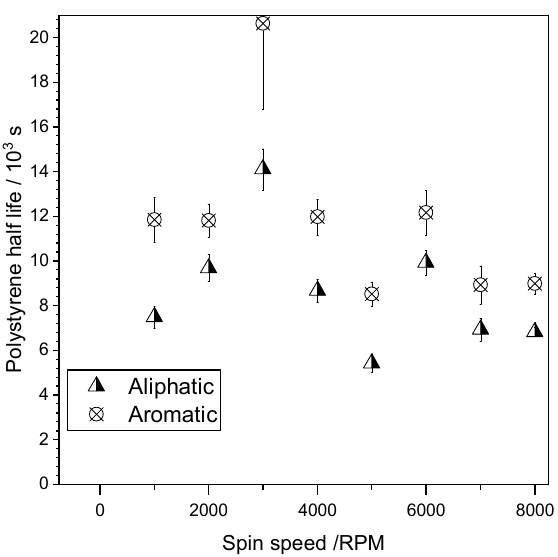
Figure 3. The effect of film deposition speed on the rate of photocatalytic decomposition of the aliphatic and aromatic C–H groups.